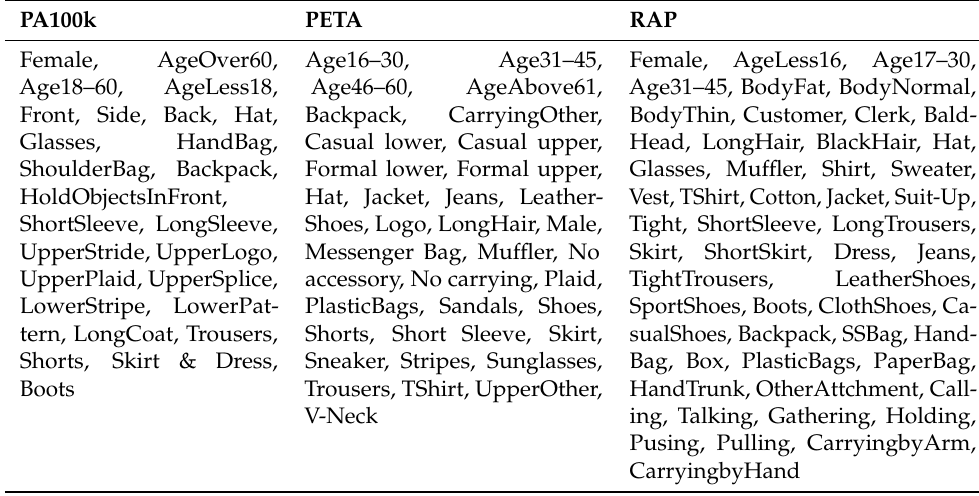
Table 1. List of attributes extracted by each network in the PAI ensemble. Each network is trained on a different dataset, with a separate set of attributes. After coalescing similar attributes and eliminating appearance-only attributes, we obtain 42 appearance